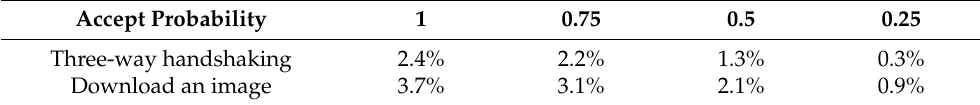
Table 5. Successful rate of three-way handshaking and downloading a 760 KB